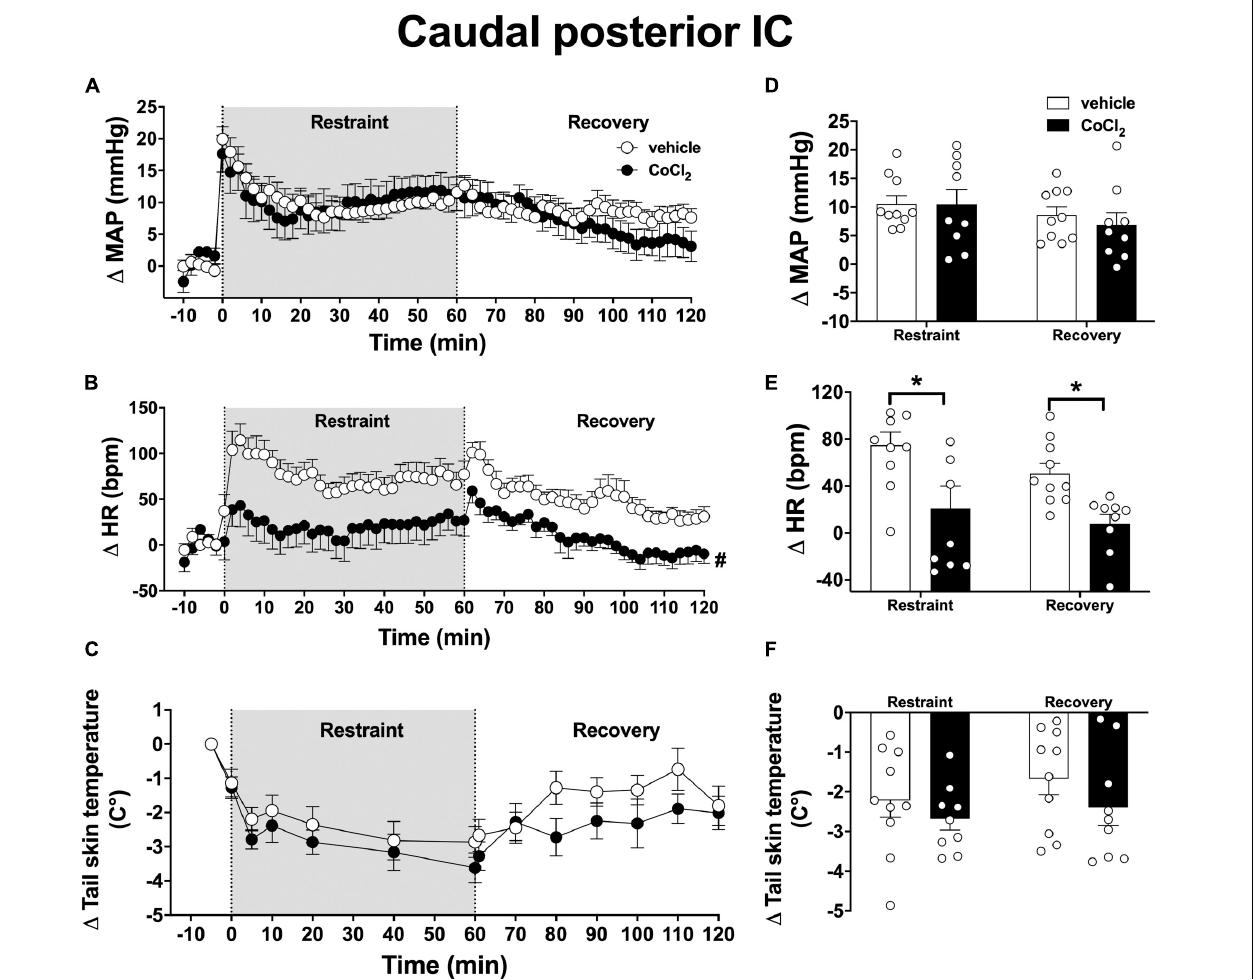
FIGURE 5 | Effect of bilateral microinjection of the non-selective synaptic inhibitor CoCl 2 into the caudal posterior subregion of the insular cortex (IC) on mean arterial pressure (MAP), heart rate (HR), and tail skin temperature responses evoked by an acute session of restraint stress. (A–C) Time-course curves of changes on MAP ( (cid:49) MAP), HR ( (cid:49) HR), and tail skin temperature ( (cid:49) tail skin temperature) evoked by acute restraint stress in animals treated bilaterally into the caudal posterior IC with vehicle (saline, 100 nl, n = 10) or the non-selective synaptic inhibitor CoCl 2 (1 mM/100 nl, n = 9). Shaded area indicates the restraint stress period. Circles represent the mean ± SEM. # p < 0.05 over the entire restraint and recovery period compared to vehicle group. Two-way ANOVA. (D–F) Mean of (cid:49) MAP, (cid:49) HR, and (cid:49) tail skin temperature during the entire restraint and recovery periods in animals treated bilaterally into the caudal posterior IC with vehicle ( n = 10) or CoCl 2 (1 nmol/100 nl, n = 9). Bars represent the mean ± SEM. * p < 0.05 compared to vehicle group. Two-way ANOVA followed by Bonferroni post-hoc